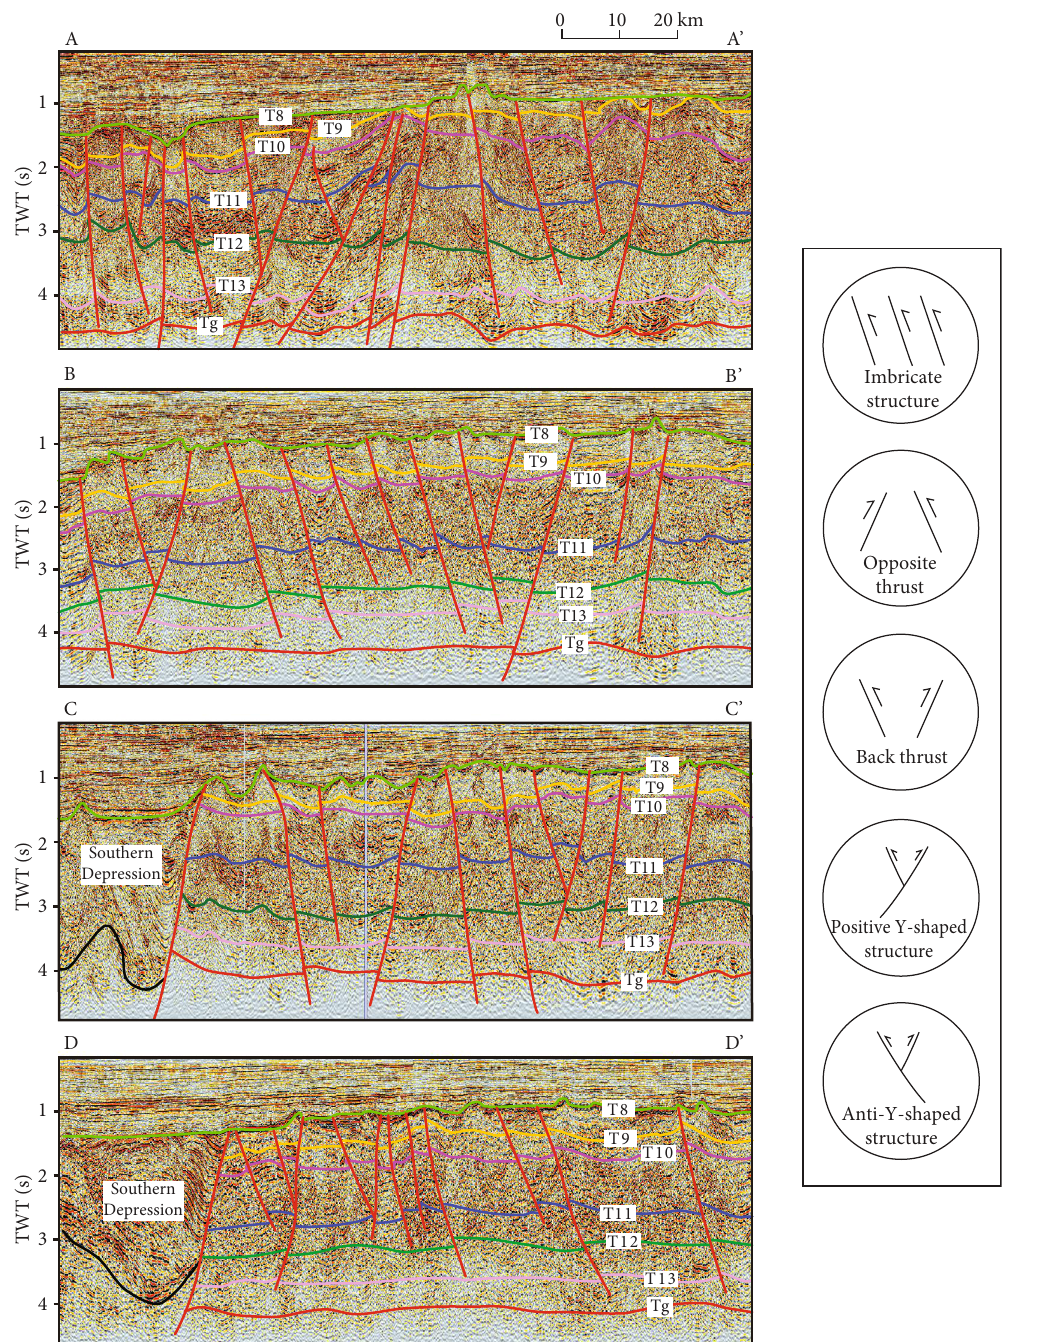
Figure 5: Characteristics of compressional structures in the seismic section of the Wunansha Uplift, South Yellow Sea basin (see Figure 1 for pro fi le